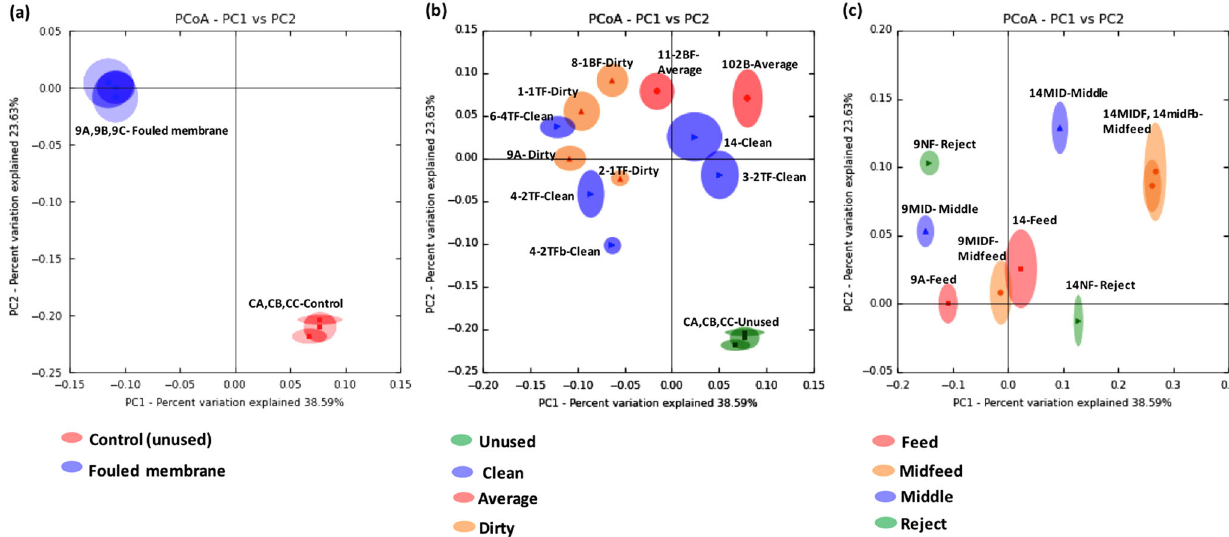
Fig. 5 Jackknifed PCoA analysis using weighted Unifrac distances of bacterial communities in the extraction replicates of control and fouled RO membranes ( a ); unused, clean, moderately fouled (average) and severely fouled (dirty) RO membranes ( b ); feed, mid-feed, middle and reject end of RO membranes ( c